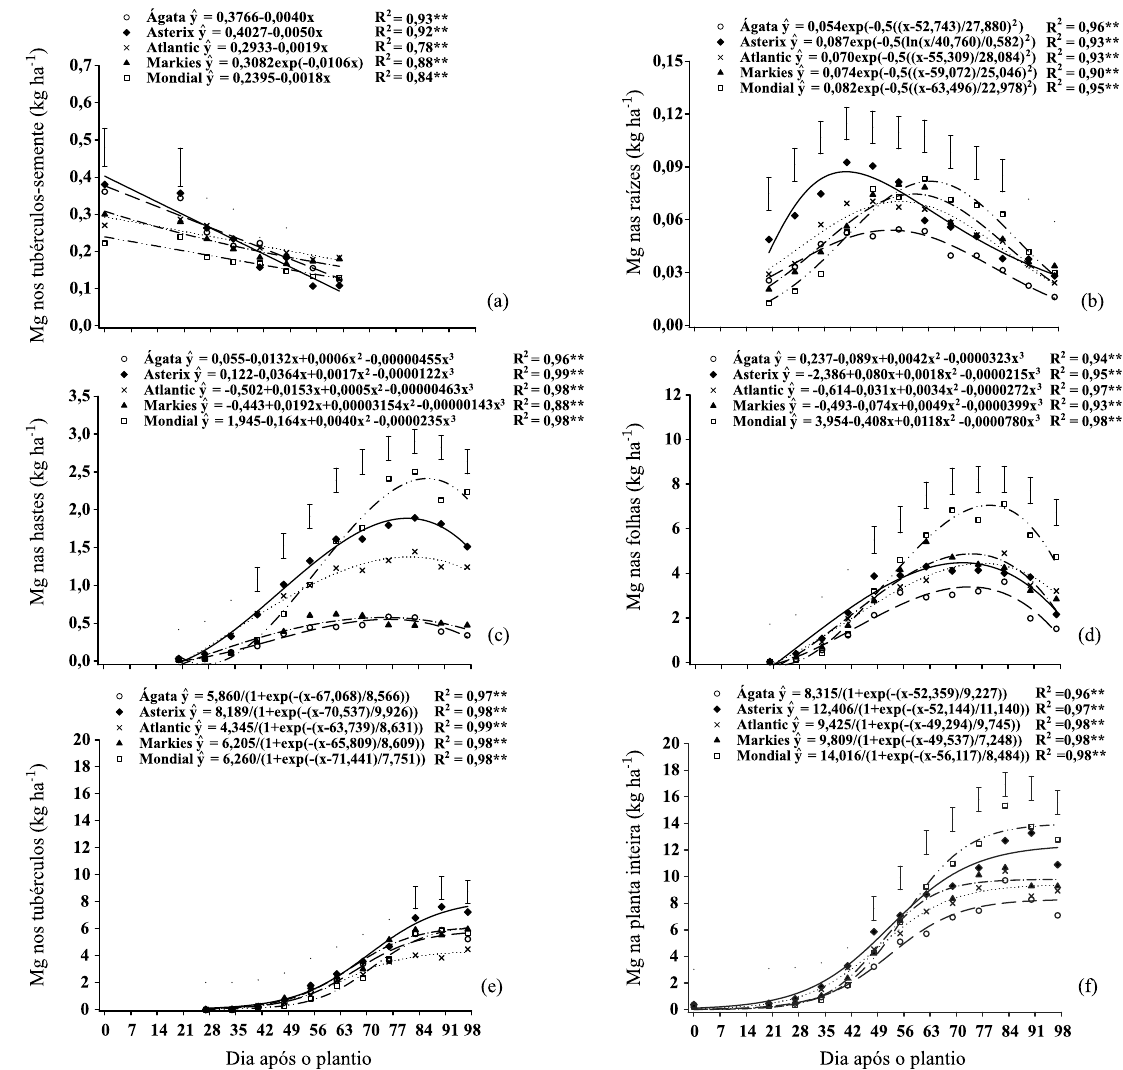
Figura 6. Quantidade de Mg nos tubérculos-semente (a), raízes (b), hastes (c), folhas (d), tubérculos (e) e na planta inteira (f) de cultivares de batata ao longo do ciclo. ** significativo a 1 % pelo teste F. Barras verticais indicam o valor de DMS pelo teste de Tukey a 5